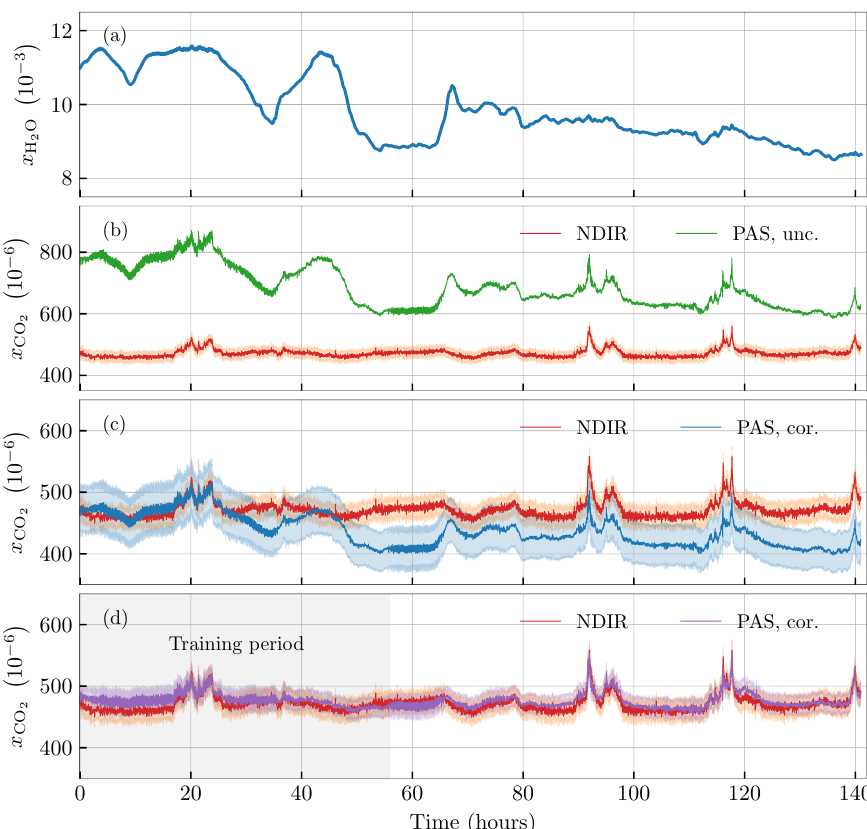
Figure 4. Carbon-dioxide monitoring over six days in atmospheric humidity levels. ( a ) measured absolute humidity; ( b ) CO 2 level deduced from PA signal, uncorrected for the atmospheric water content; ( c ) CO 2 level deduced from PA signal, corrected for the atmospheric water content using parameters from the calibration (Figure 3); ( d ) CO 2 level deduced from PA signal, corrected for the atmospheric water content using a model based on “historical” training data from the shaded time period. The shaded regions around each curve represent the calculated 1 σ confidence region for each time